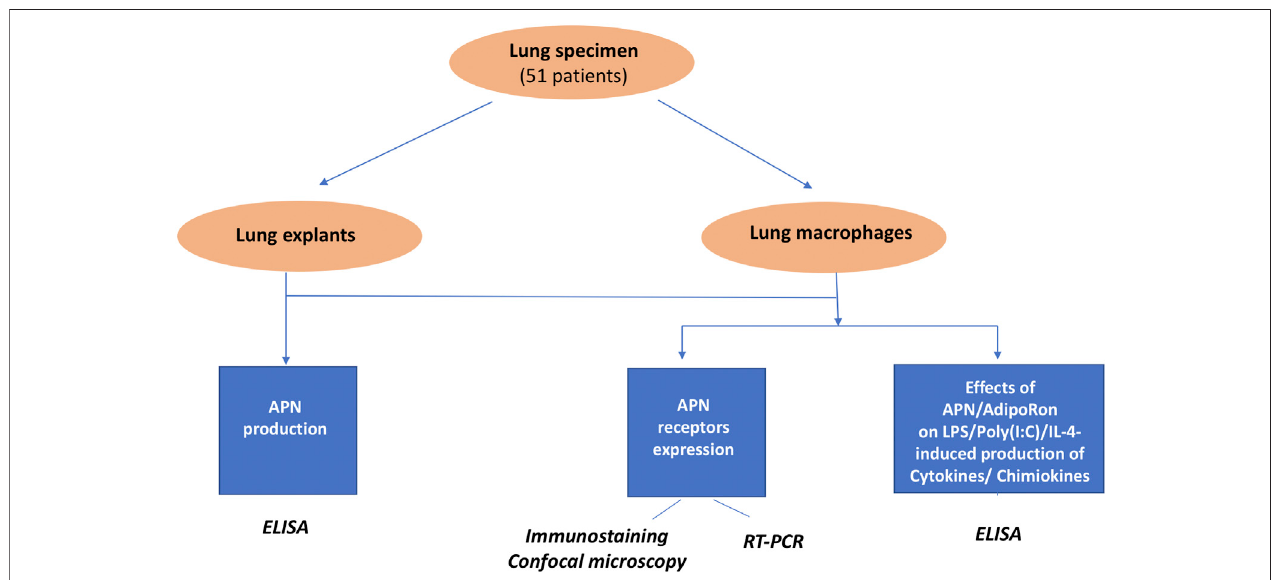
FIGURE 1 | Experimental